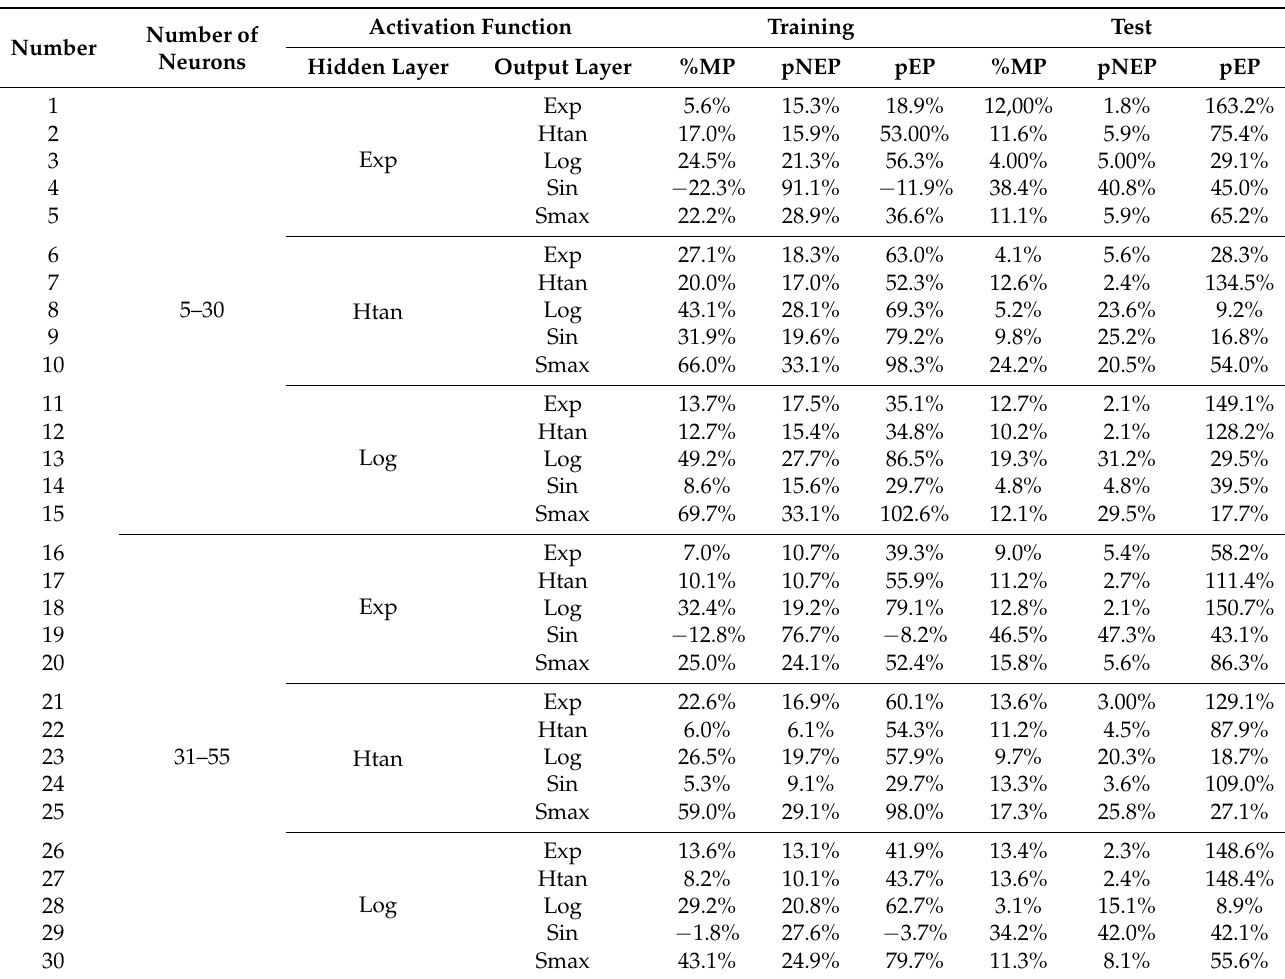
Table 3. List for the best neural networks based on the maximisation of pNEP